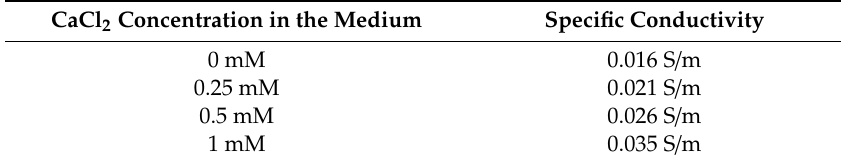
Table 1. The measured specific conductivity of used electroporation media containing di ff erent concentrations of CaCl 2 . Measurements were done using conductometer (Mettler Toledo